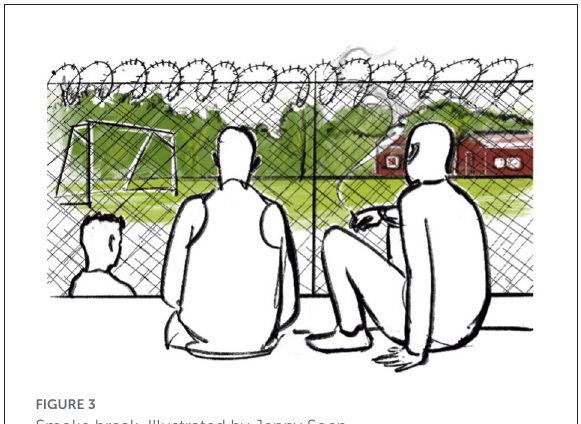
FIGURE3 Smoke break. Illustrated by Jenny